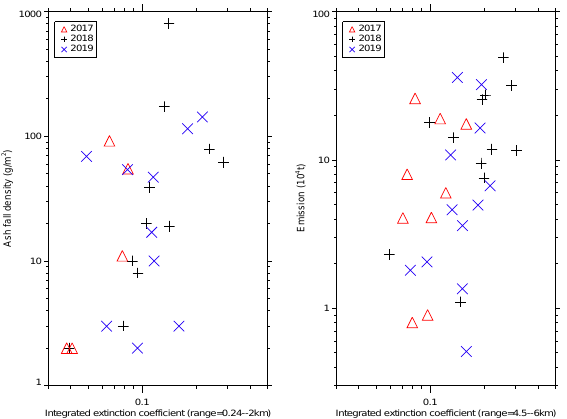
Figure 6. Scatter diagrams between the monthly means of: ( left ) the integrated extinction coefficient within 0.24–2 km of the lidar and ash fall density at JMA’s Kagoshima observatory; and ( right ) the integrated extinction coefficient within 4.5–6 km of the lidar and estimated mass of ash